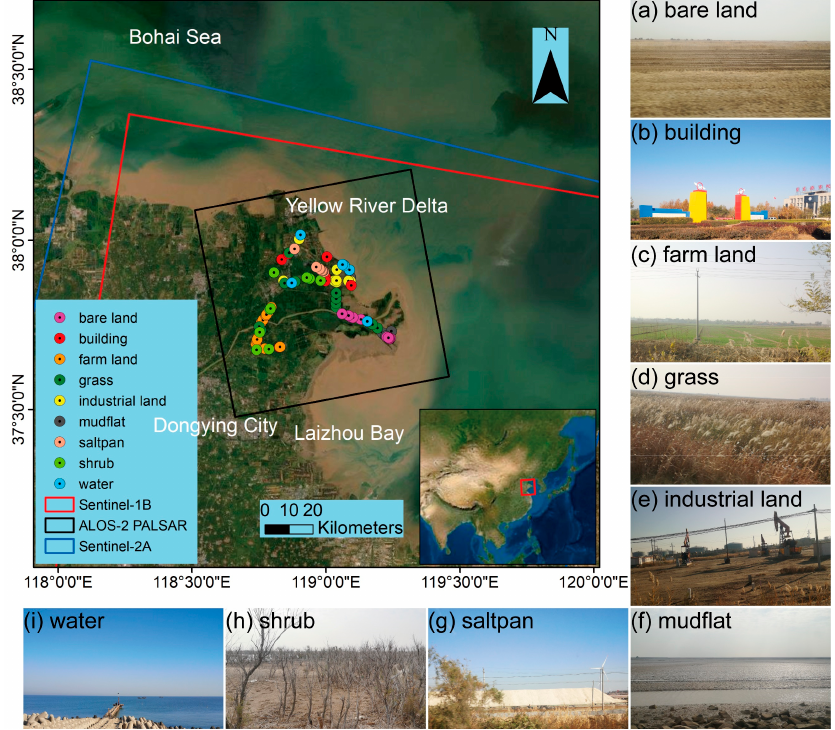
Figure 1. Study area and coverage of satellite images used in this study. The black, red, and blue boxes in the left-top indicate the coverage of ALOS-2 PALSAR, Sentinel-1B, and Sentinel-2A images, respectively. Subplots from ( a – i ) show pictures of typical land cover over the YRD taken in November 2021.